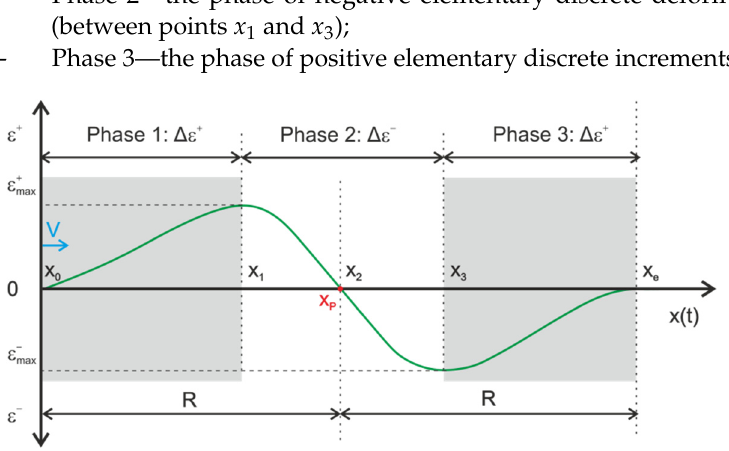
Figure 4. Full characteristics of the deformation profile for the point P for the longwall operations that are shown in Figure 3 (own study).